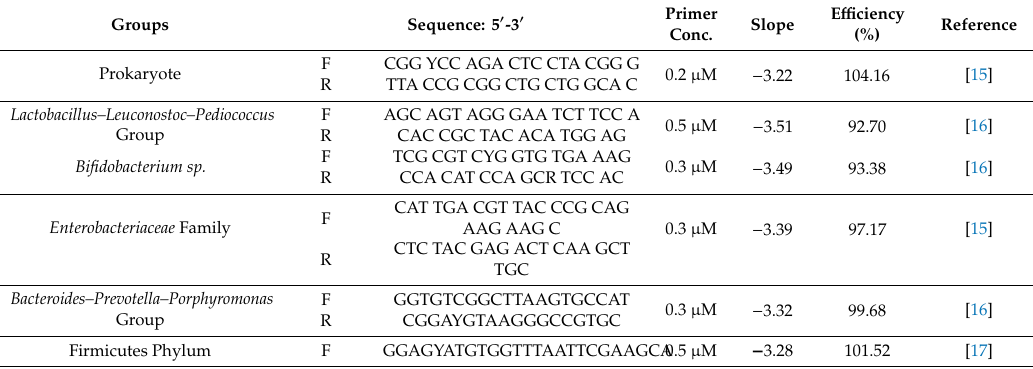
Table 2. Primer sequences and conditions used in the qPCR